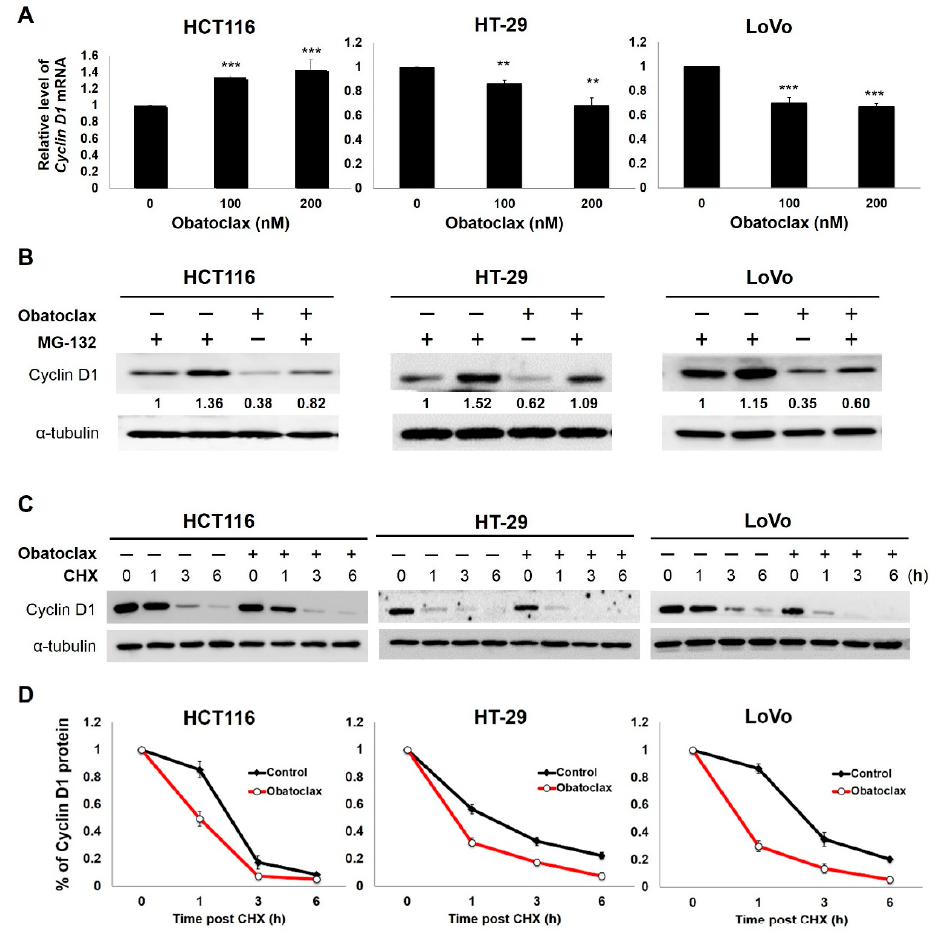
Figure 3. Obatoclax targets cyclin D1 for proteasome-mediated degradation. ( A ) Cell line-dependence of the effect of obatoclax on cyclin D1 mRNA expression. HCT116, HT-29, and LoVo cells were stimulated by obatoclax (0, 100, 200 nM) for 24 h, followed by determination of cyclin D1 mRNA levels using quantitative real-time reverse transcription-polymerase chain reaction (RT-PCR) analysis. Data were presented as the percentage relative to the drug-untreated control. **: p < 0.01. ***: p < 0.001; ( B ) Blockade of proteasome-mediated degradation restores cyclin D1 levels downregulated by obatoclax. HCT116, HT-29, and LoVo cells were treated with obatoclax (0, 100, 200 nM) for 24 h. The proteasome inhibitor MG-132 was then added to obatoclax-treating cells and the MG-132 co-treatment was allowed to occur for 2 h, followed by cyclin D1 immunoblotting. It is noticed that cyclin D1 levels were significantly rescued by the MG-132 co-treatment. α -Tubulin levels served as the control for equal loading; ( C ) Obatoclax destabilizes cyclin D1. HCT116, HT-29, and LoVo cells were treated with obatoclax (200 nM) for 24 h and then subject to cycloheximide chase analysis. The levels of cyclin D1 at 0, 1, 3, and 6 h after cycloheximide treatment were determined using immunoblot analysis. α -Tubulin levels served as the control for equal loading; ( D ) Obatoclax elevates the rate of cyclin D1 protein degradation. The signal density of each band in the blots shown in ( C ) was quantified using ImageJ 1.48s algorithms and then plotted against the length of time after cycloheximide treatment. Data were presented as the percentage relative to the drug-untreated control. Data indicated that the half-life of cyclin D1 protein was dropped from 1.48 to 0.49 h in HCT116 cells, from 1.55 to 0.74 h in HT-29 cells, and from 2.42 to 0.71 h in LoVo